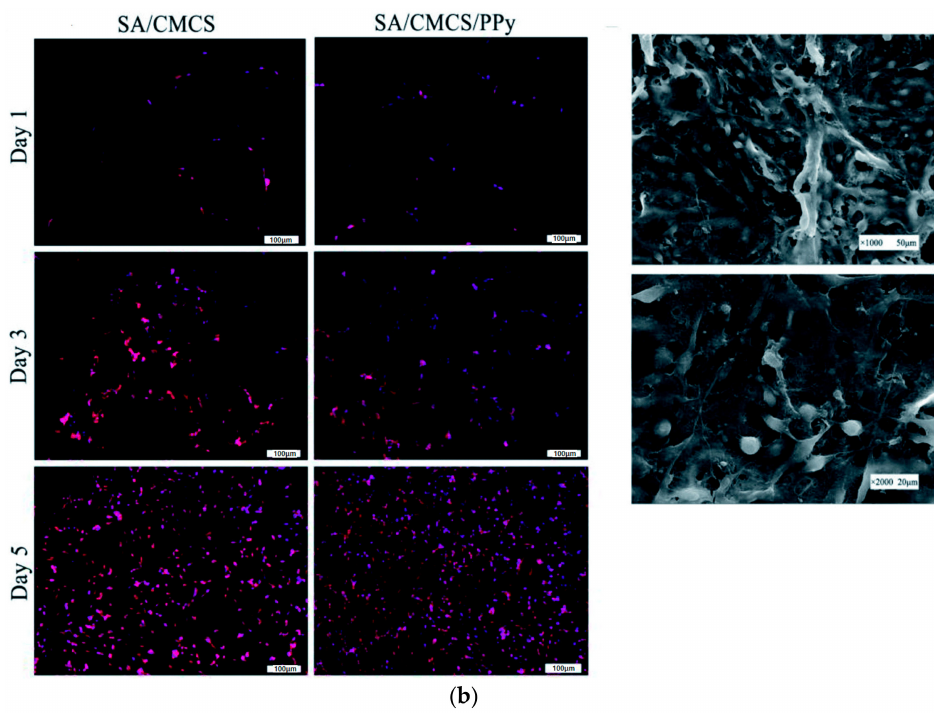
Figure 15. Conductive sodium alginate, PPy, and CMCS hydrogels to aid in peripheral nerve regeneration. ( a ) Sodium alginate/CMCS/PPy hydrogel was successfully synthesized; ( b ) PC12 cells on sodium alginate/CMCS and sodium alginate/CMCS/PPy hydrogel. PC12 cells grew well and adhered to sodium alginate/CMCS/PPy more effectively compared to the control sample (reproduced from [169] under open access